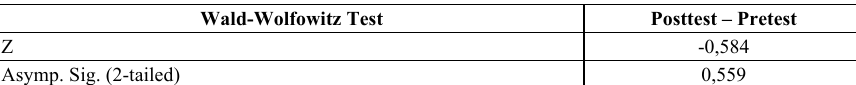
Table 10. The results of the conventional model learning effectiveness